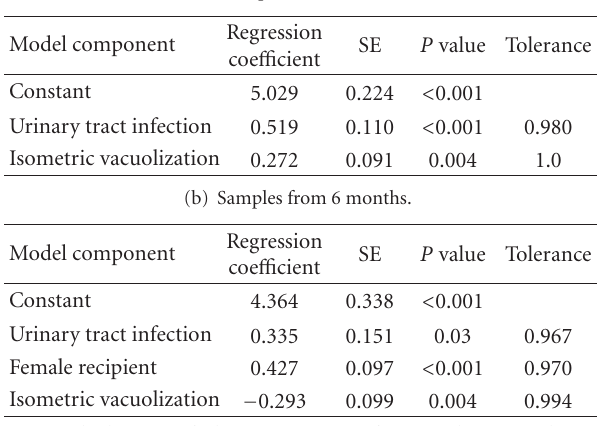
Table 3: Linear regression analysis of significant correlates to uNGAL excretion. (a) Samples from 6 weeks.